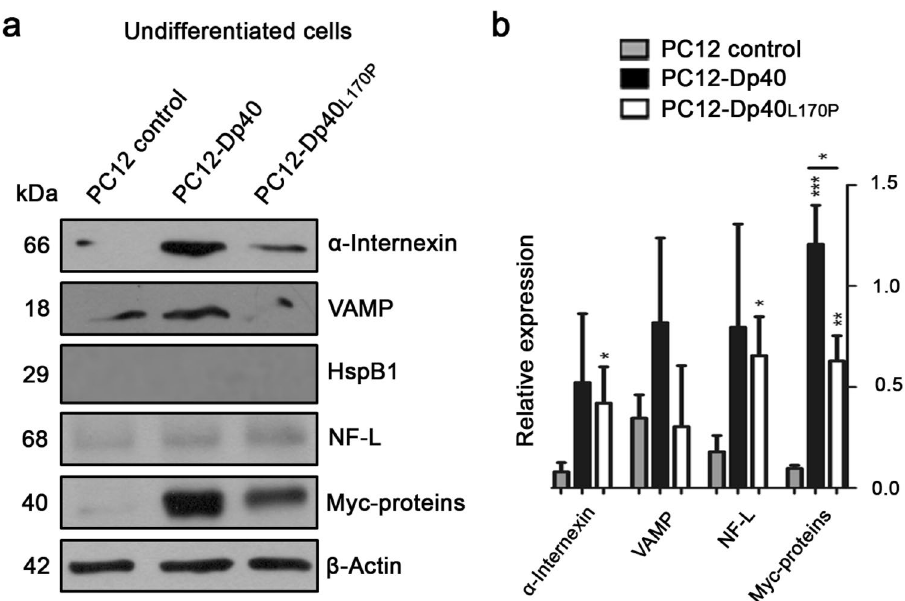
Figure 3. Expression of the proteins α-internexin, VAMP, HspB1, NF-L, Myc-Dp40 and Myc-Dp40 L170P in the undifferentiated PC12-Dp40 and PC12-Dp40 L170P cells. Protein extracts were obtained from the undifferentiated PC12 control, PC12-Dp40 and Dp40 L170P cells and analyzed by WB. ( a ) Expression of α-internexin, VAMP, HspB1, NF-L, HspB1, Myc-Dp40 and Myc-Dp40 L170P . ( b ) Relative expression of α-internexin, VAMP, and NF-L was determined as indicated in the materials and methods. The graph represents the mean ± SD from three independent experiments. * P ˂ 0.034 and 0.016 for α-internexin and NF-L comparing the PC12 control cells and the PC12-Dp40 L170P cells. *** P ˂ 0.0006 and ** P ˂ 0.0018 for Myc-Dp40 and Myc-Dp40 L170P comparing the PC12-Dp40 and